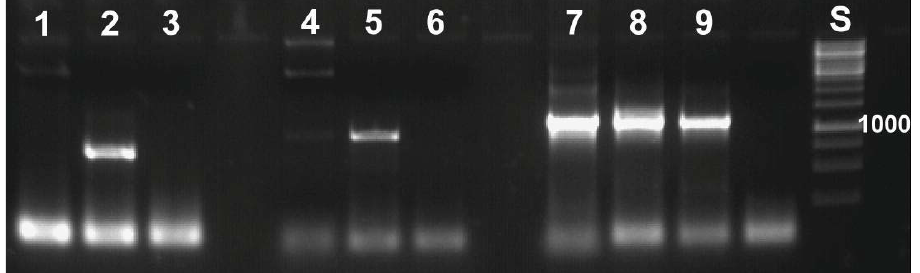
Figure 4. Specific primers developed for reed beetle symbionts do not yield a PCR product with standard laboratory strains of E. coli (1% agarose gel containing ethidium bromide, UV